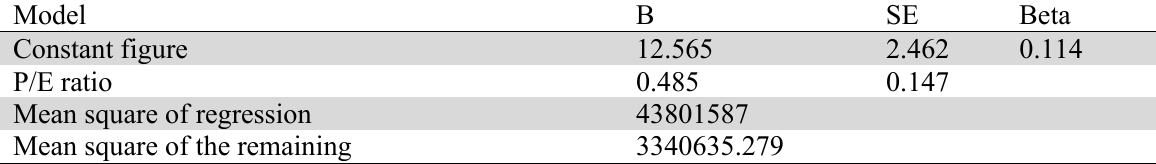
Estimation of the simple linear regression between P/E and stock returns Model